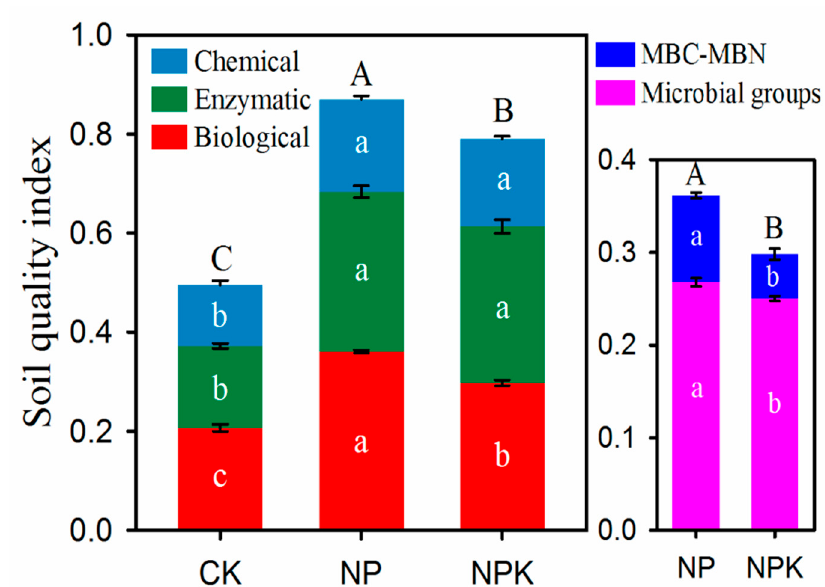
Figure 6. Comparison of SQI scores among different long-term fertilizer treatments (CK, no fertilizer; NP, nitrogen and phosphorous fertilizer; NPK, nitrogen, phosphorus, and potassium fertilizer). Vertical bars represent the standard error ( n = 3). Different lowercase letters indicate significant differences among fertilizer treatments for the SQI scores obtained from each group with similar variables ( p < 0.05). Different uppercase letters indicate significant differences among fertilizer treatments for the total SQI scores obtained from the combined groups ( p < 0.05).